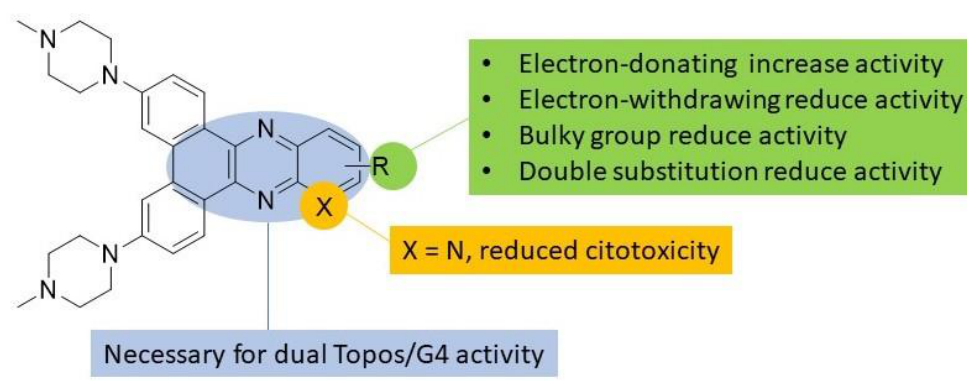
Figure 5. Graphical representation of the dibenzoquinoxalines’ functional groups necessary for the interaction with the target proteins.